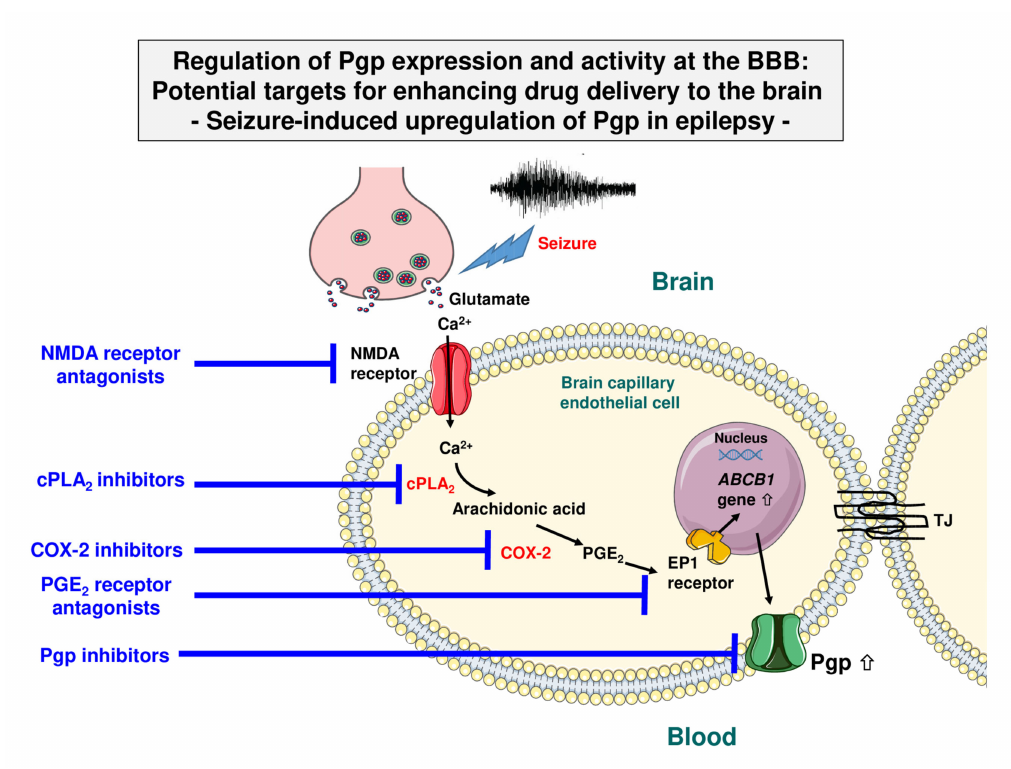
Figure 2. Signaling pathway in brain capillaries mediating the seizure-induced overexpression of Pgp. Seizure-induced release of glutamate signals through the N-methyl-D-aspartate (NMDA) receptor, which leads to activation of cytosolic phospholipase A2 (cPLA 2 ). In turn, this leads to the release of arachidonic acid, which cyclooxygenase 2 (COX-2) converts to PGE 2 , which, via the PGE 2 (EP1) receptor, leads to the transcriptional activation of ABCB1 ( MDR1 ) and thus increased Pgp expression and transport activity levels at the BBB. The downstream event of EP1 receptors, which drives transcriptional activation of the Pgp encoding gene, is not clear, but the transcription factor NF- κ B (nuclear factor κ B) has been proposed to act as a master regulator of ATP-binding cassette (ABC) transporter expression in brain capillaries [35]. Note that the di ff erent cell and vesicle types are not drawn to scale. Modified from Potschka [36] and Hartz et al.